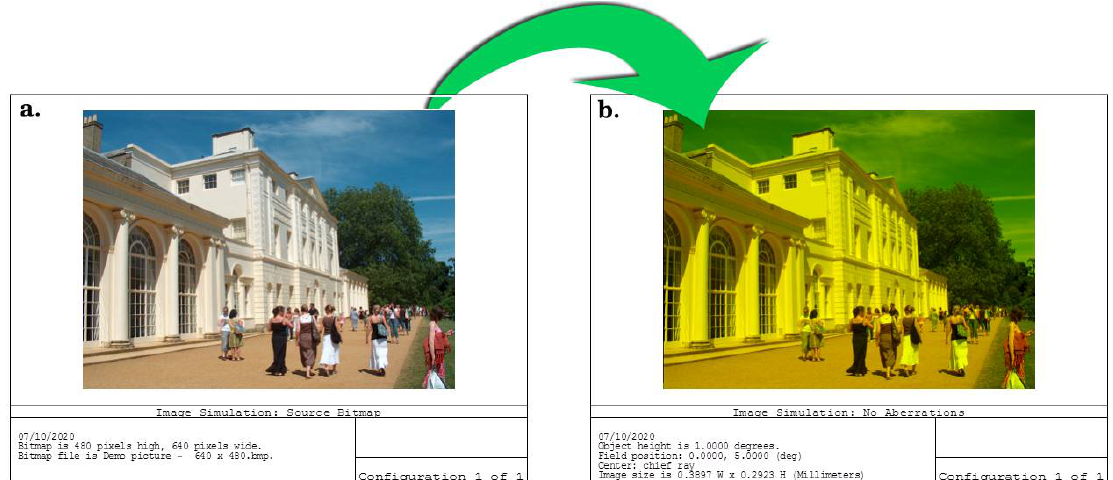
Figure 8. ( a ) The retinal image resulting from the eye with a PMMA-TiO 2 contact lens; ( b ) the retinal image resulting from the eye with a PMMA-TiO 2 contact lens coated with Er 3+ /TiO 2 NPs.